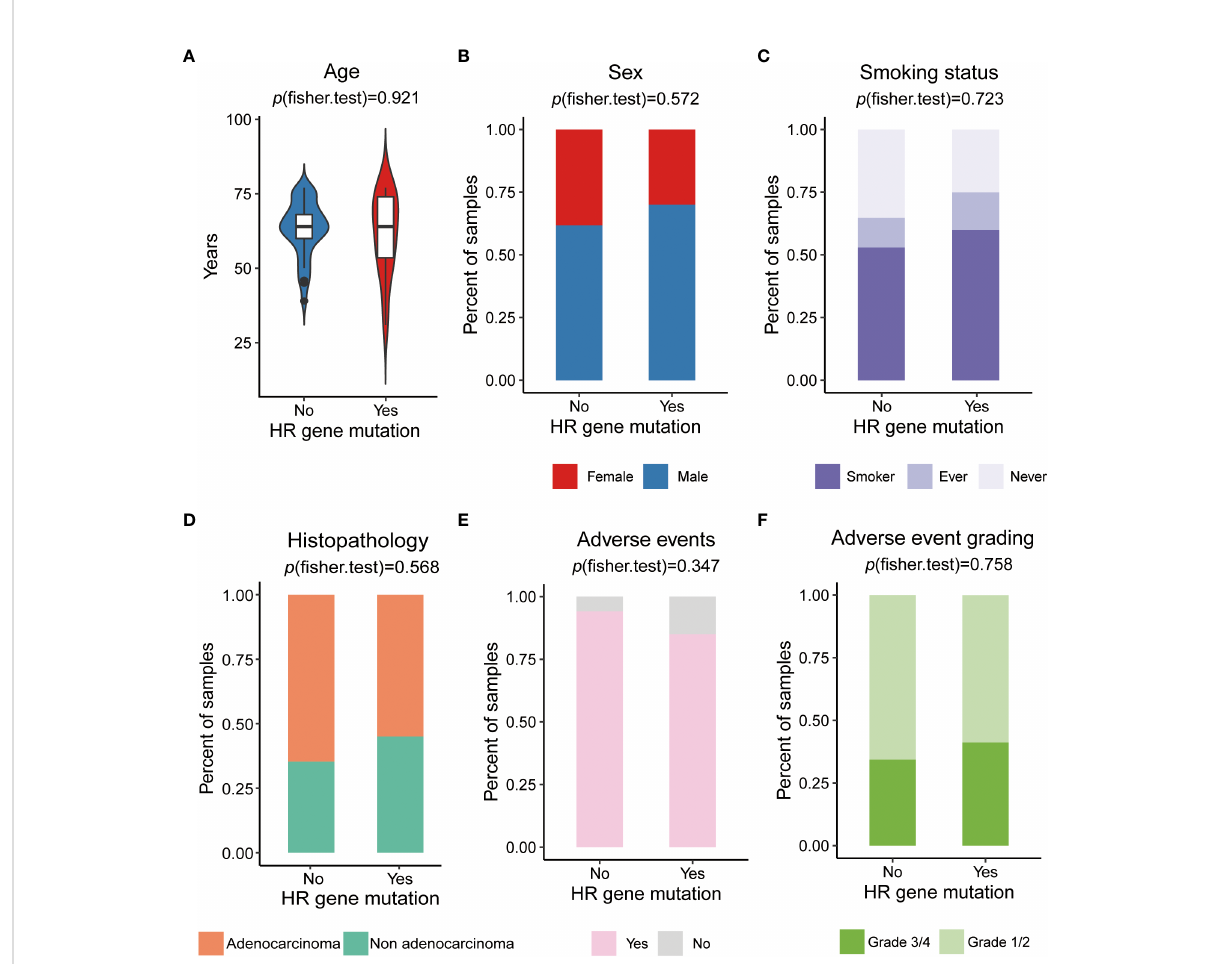
FIGURE 4 The relationship of HR gene mutations and clinical factors (A) Comparison of ages between HR mutation and wild-type groups. (B) Comparison of sex proportion differences in patients between HR gene mutation and wild-type groups. (C) Comparison of the differences in proportion of patients with a history of smoking between the HR gene mutation and wild-type groups. (D) Comparison of the differences in the proportion of patients related to histopathology type between the HR gene mutation and wild-type groups. (E) Comparison of the differences in the proportion of patient related to the occurrence of adverse events between the HR gene mutation and wild-type groups. (F) Comparison of the differences in the proportion of patients related to the incidence of grade 3/4 adverse events between the HR gene mutation and wild-type